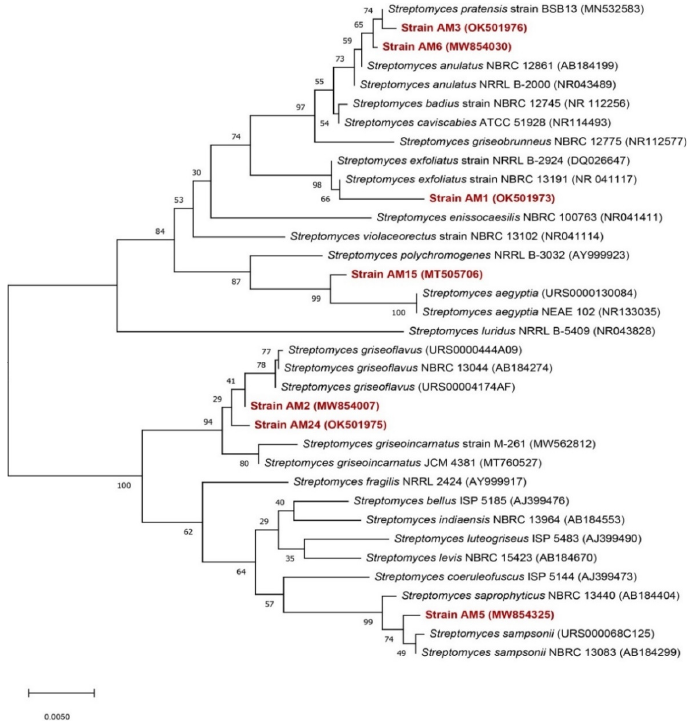
Figure 4. Neighbor-joining phylogenetic tree of the 7 isolated strains and 28 Streptomyces species based on nearly complete 16S rRNA gene sequences (1400 nt). Numbers at the nodes indicate levels of bootstrap support (%) based on a neighbor-joining analysis of 1000 resampled datasets; only values >50% are given. Accession numbers are given in parentheses.